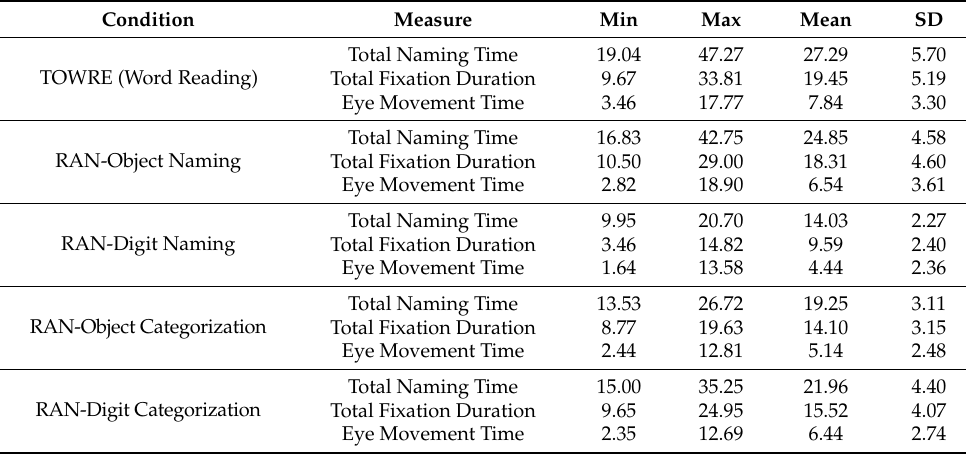
Table 3. Descriptive statistics for all the variables in the study ( n = 37) (in